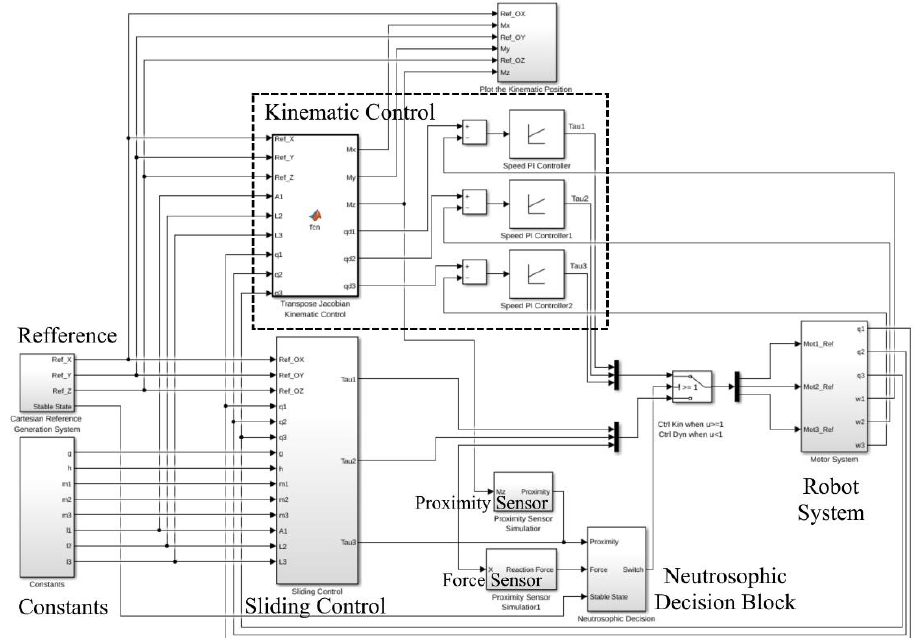
Figure 10. MATLAB Simulink diagram for the hybrid control.